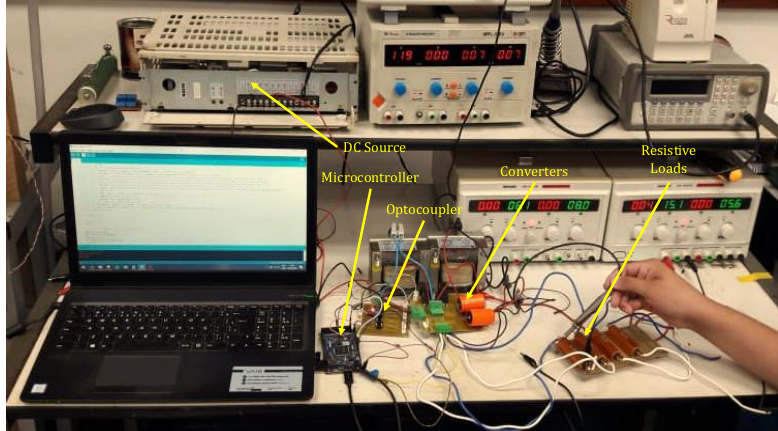
Figure 14. Experiment bench set up for testing.